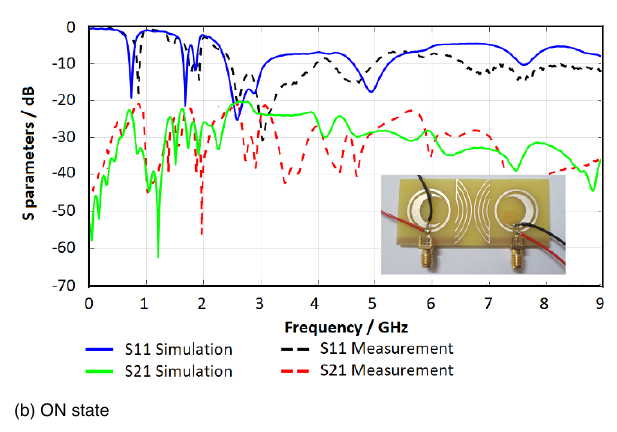
FIGURE 15. Measured antenna with decoupling